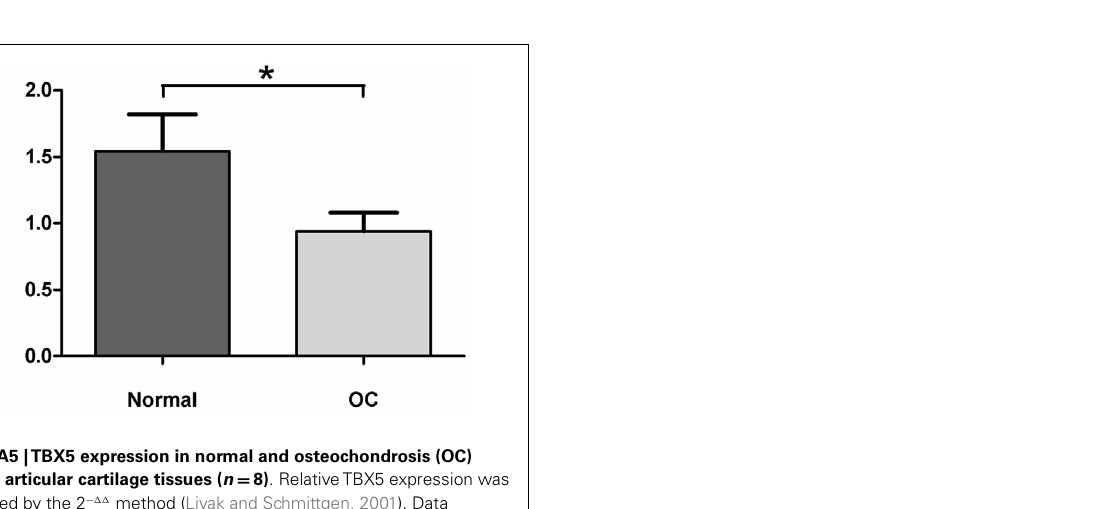
FIGUREA4 |A molecular network of theTBX5 gene with genes assigned to SSC2 87.3–115.0Mb marked in blue derived by Ingenuity PathwayAnalysis (IPA) .The network belongs to IP biofunctions embryonic development, organismal development, and skeletal and muscular system development and function.